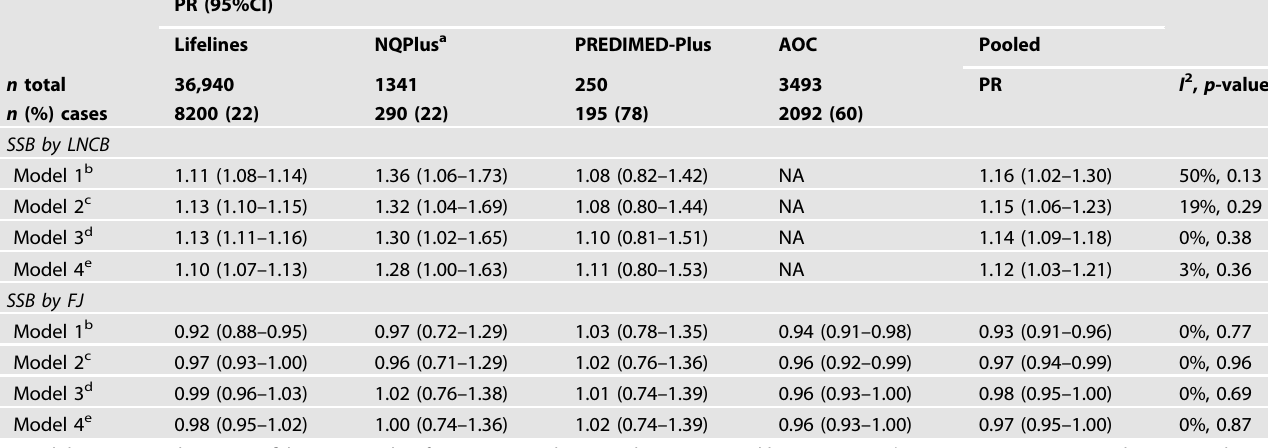
Table 4. Adjusted associations of SSB, LNCB, and FJ consumption and FLI-de fi ned NAFLD prevalence when replacing SSB with the same amount of LNCB or FJ.